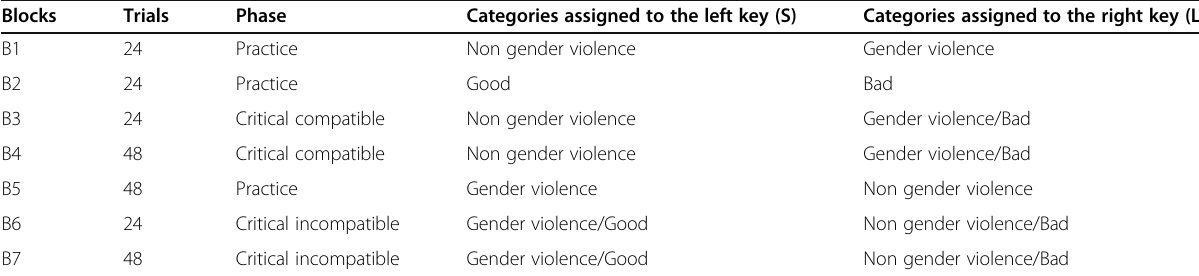
Table 1 Sequence of stimuli presentation initiating the IAT with the compatible critical phase Blocks Trials Phase Categories assigned to the left key